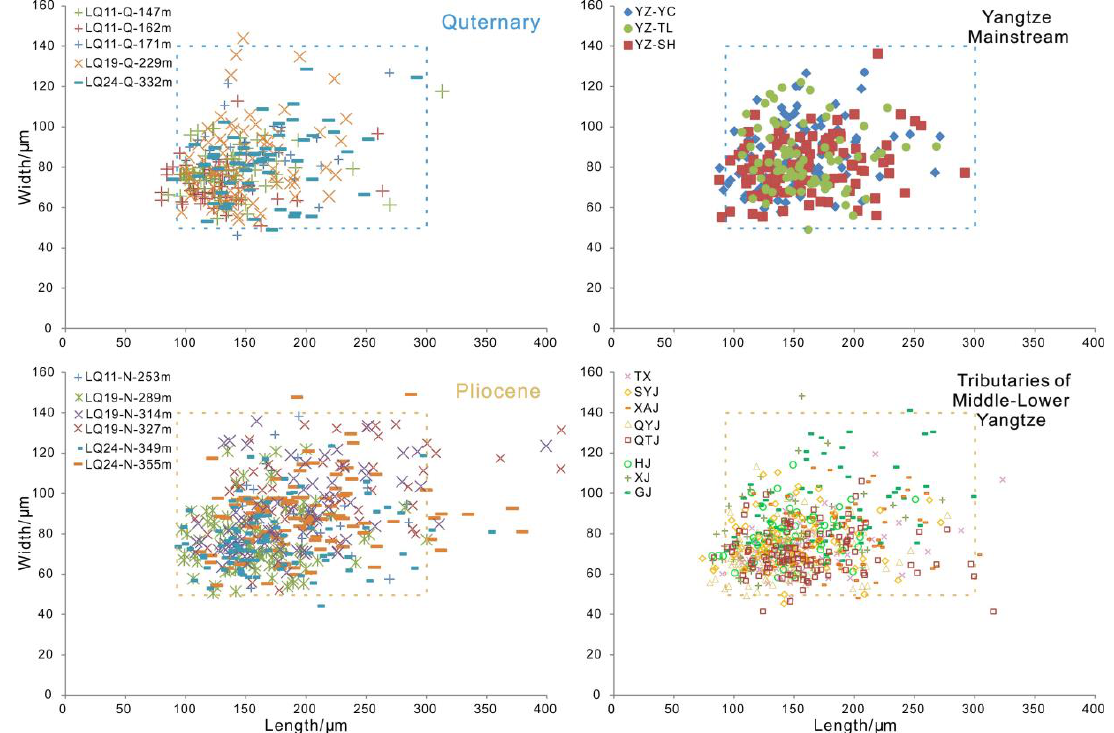
Figure 6. Length and width statistics of detrital zircon in the modern river sediment and core sediment of LQ11, LQ19, and LQ24. Q = Quaternary, N = Pliocene. Please see Figure 1 for explanation of the abbreviations of capital letters.